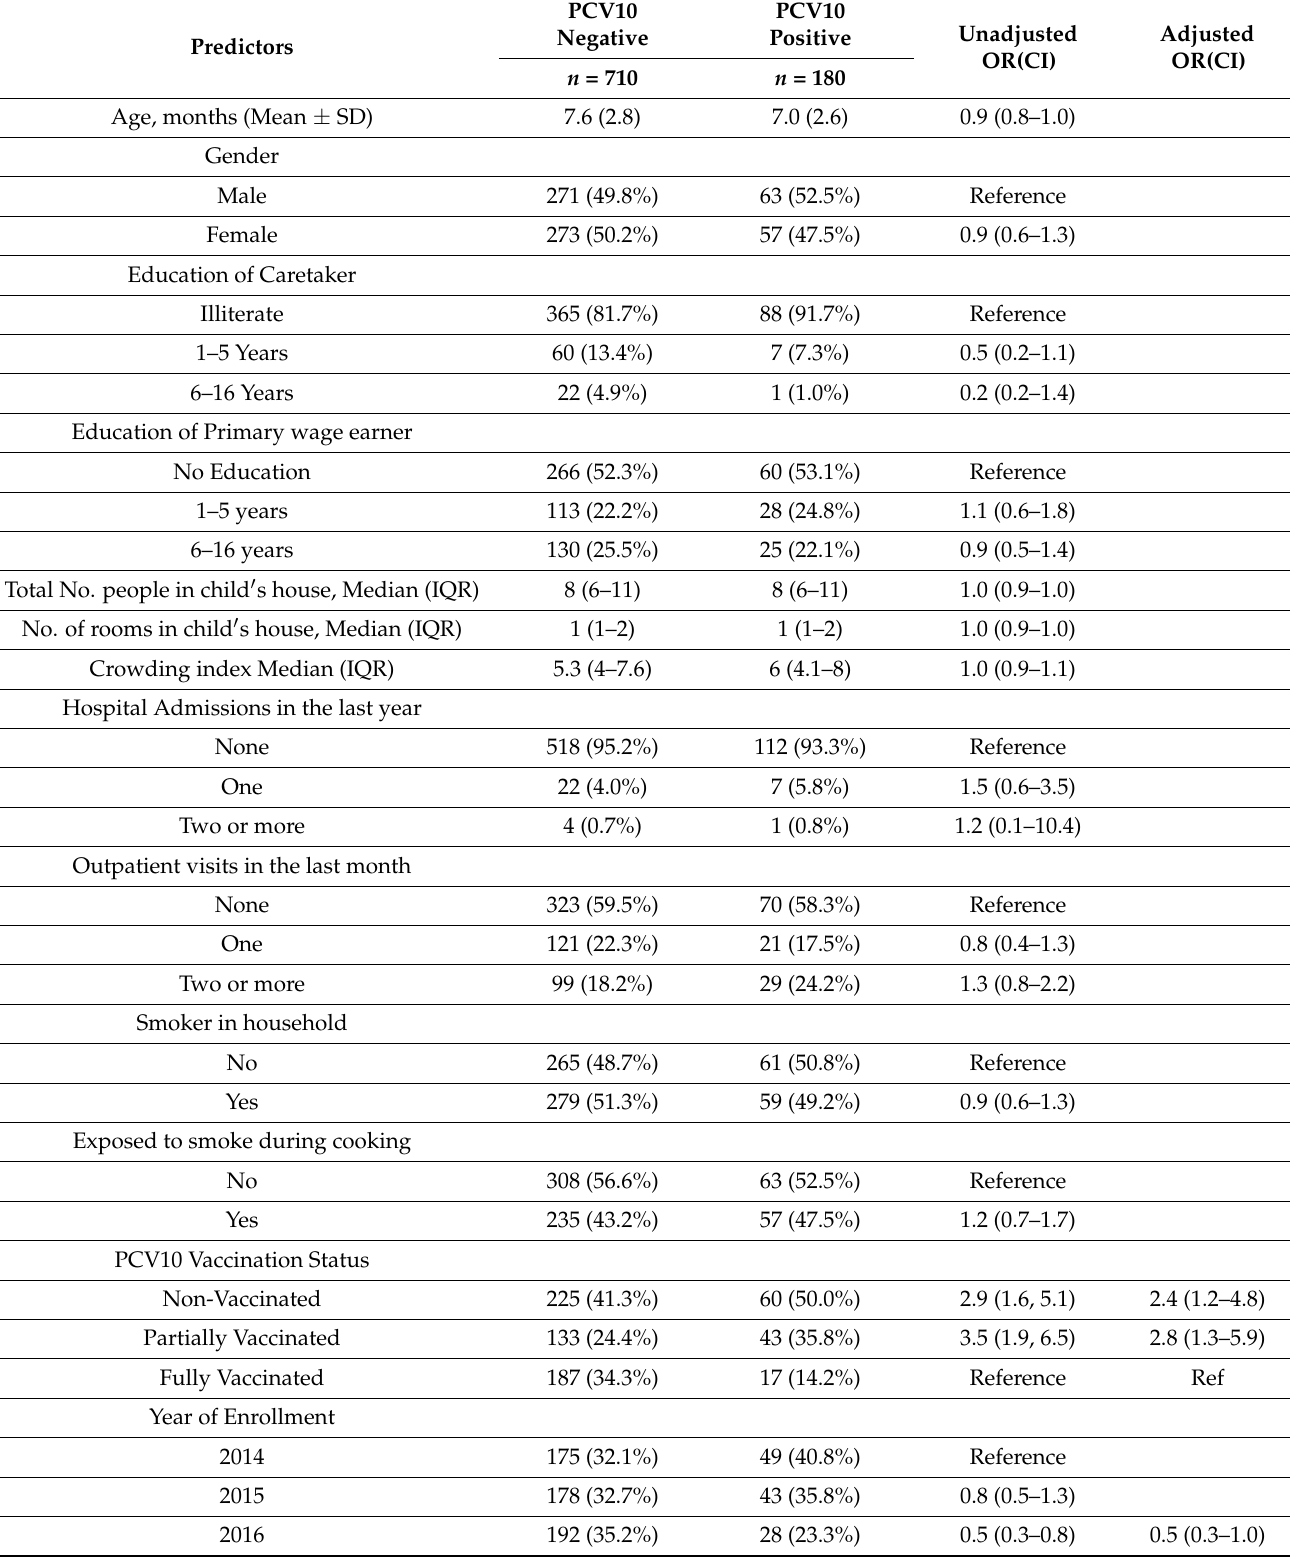
Table 6. Factors associated with the carriage of PCV10-serotype pneumococci among study